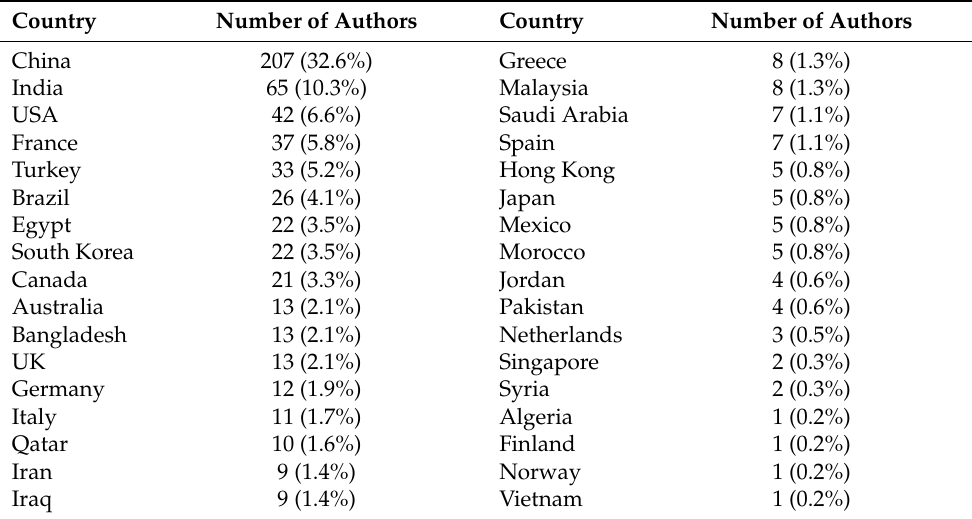
Table A2. Distribution of authors by